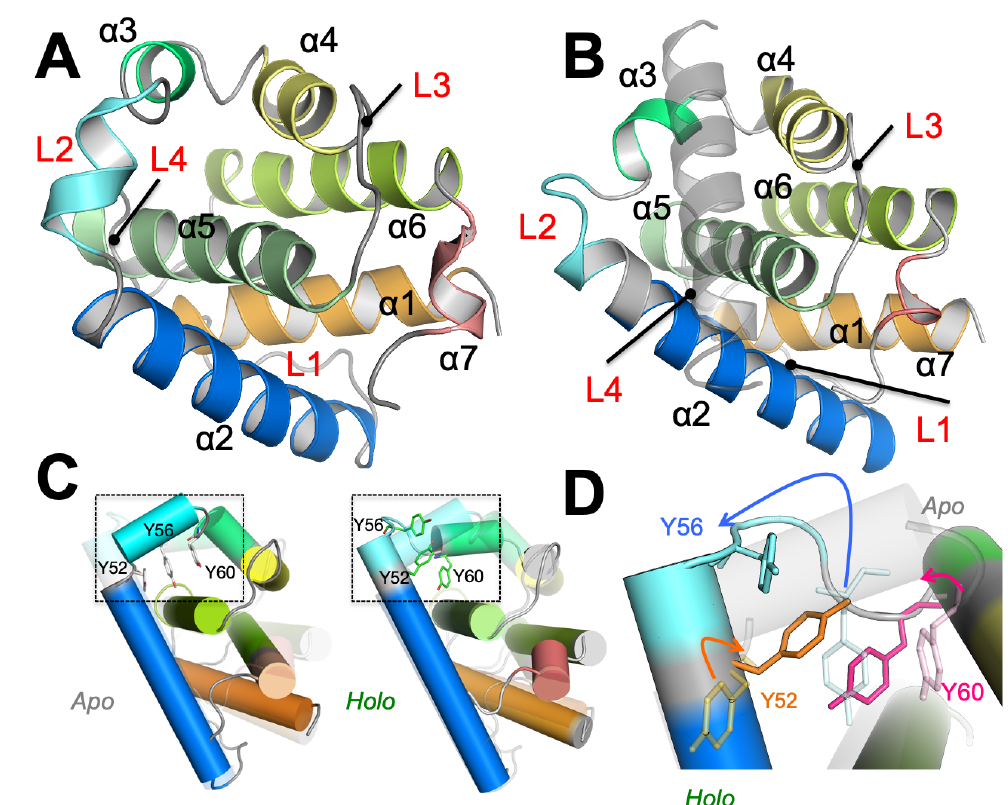
Figure 1. Conformational changes in apo- and holo-M11 . M11 helices are delineated by different colors. ( A ) Apo-M11 (PDB: 2ABO) and ( B ) Holo-M11 (PDB: 3DVU). The BECN1 BH3D is displayed as a gray transparent helix. The flexible loops between the different α helices: α 1– α 2 (L1), α 2– α 3 (L2), α 4– α 5 (L3) and α 5– α 6 (L4) are labelled in red. ( C ) The apo- and holo-M11 when superimposed have an root mean squared deviation of 1.8 Å. We separately depict the apo- and holo-M11 structures. Notably, structural overlap depicts differences in loop areas farther away from the binding groove (highlighted by a dotted rectangle. ( D ) A close-up of the dotted rectangle highlighted in ( C ) shows the differences between the apo- and holo-M11 structures in the vicinity of the BH3D binding site. Notably, Tyr52, Tyr56, and Tyr60 undergo significant conformational changes that are highlighted by the colored